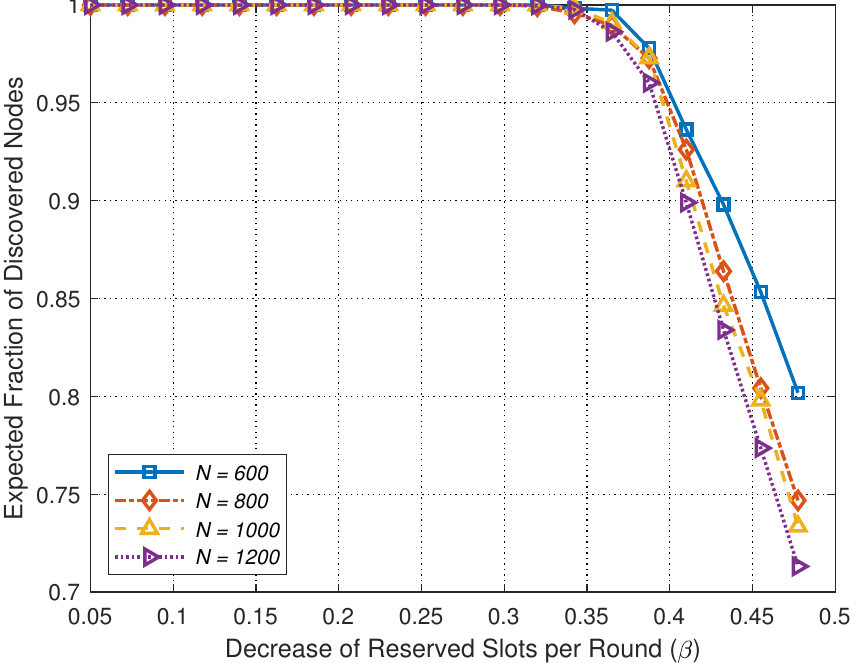
Figure 16. Fraction of discovery vs. β